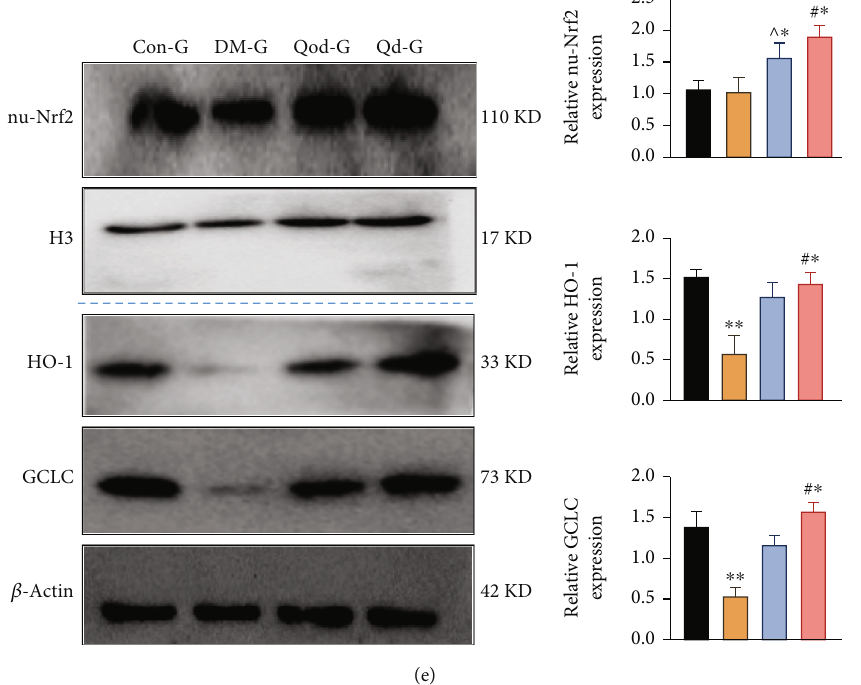
Figure 1: Quercetin ameliorates myocardial fi brosis in diabetic rats (a) ELISA assays for detecting the expression levels of NF- κ B, IL-1, TGF- α , and BNP in the serum of rats in each group. (b) Expression levels of pyroptosis pathway-associated proteins in the myocardial tissue of rats in each group detected by western blotting (WB). (c) H&E and Masson ’ s trichrome staining of rat myocardial tissues, and immuno fl uorescence detection of the expression of collagen II in myocardial tissues ( 200 × magni fi cation). Quantitative analysis of the expression of collagen II in Masson ’ s-stained sections and NLRP3 immunohistochemistry using ImageJ. (d) TUNEL assay detecting the apoptotic levels of myocardial tissue cells in each group ( 200 × magni fi cation). (e) Expression levels of Nrf2 in the nucleus and those of HO-1 and GCLC in the cell were detected by WB. H3: histone H3, used as a reference nuclear protein for normalization. CON-Group: control group; DM-Group: diabetic group; Qod-Group: interval dosing+diabetic group; Qd-Group: daily dosing and diabetic group; WB: western blotting. Data are expressed as the mean ± SD , ∗∗ P < 0 : 001 , DM-G vs. Con-G, and Qod-G. # ∗ P < 0 : 001 , Qod-G vs. Qd-G. ^ ∗ P < 0 : 001 , Qod-G vs. Con-G, and